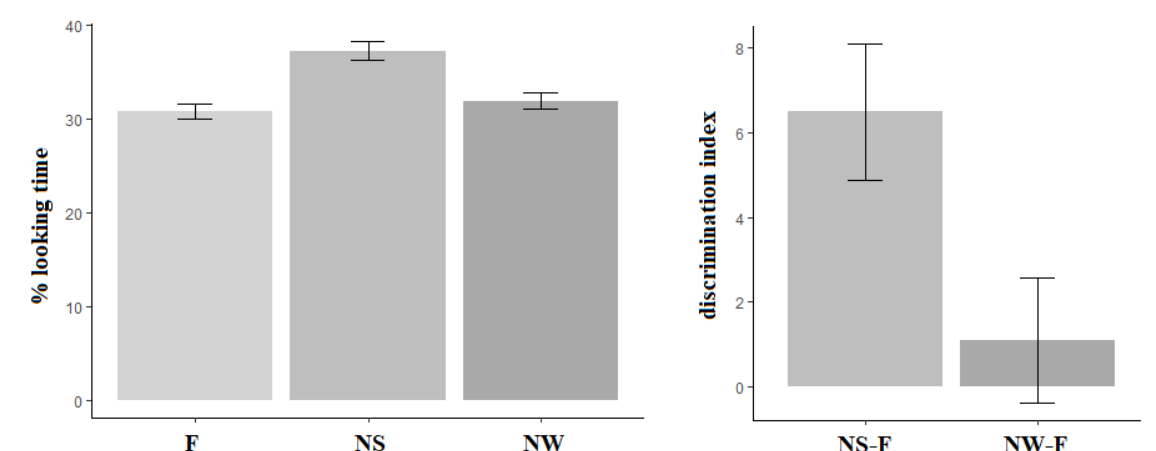
Figure 5. Bar plots in the left panel: the percentage of listening time and associated standard error during the discrimination